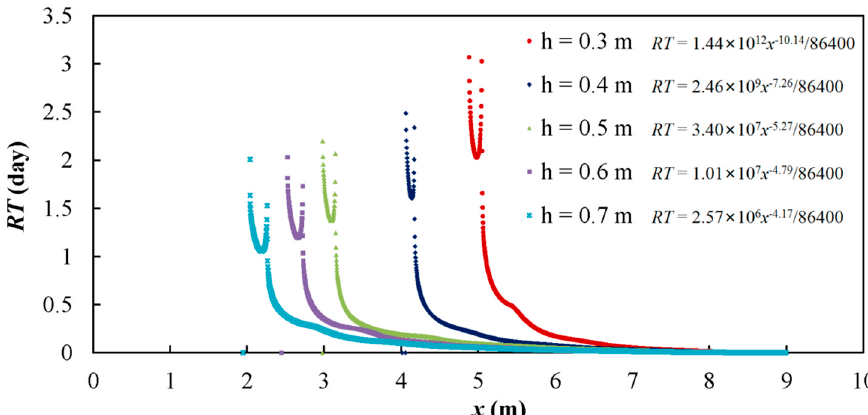
Figure 3. Relationship between the residence time ( RT ) and the location along the stream ( x ) under the five modeling scenarios with different heights of the weir ( h ). Table 2. The coefficients of the regression equations for calculating the residence time ( RT ) under the five modeling scenarios with different heights of the weir ( h ), and their R 2 values.